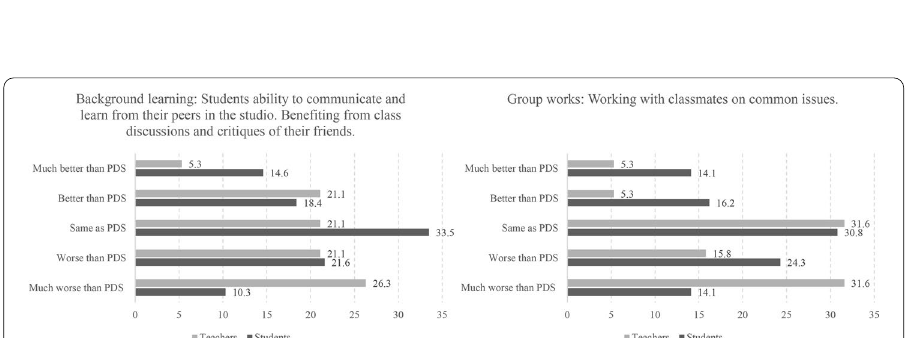
Fig. 5 Left, background peer learning; right, conducting group work